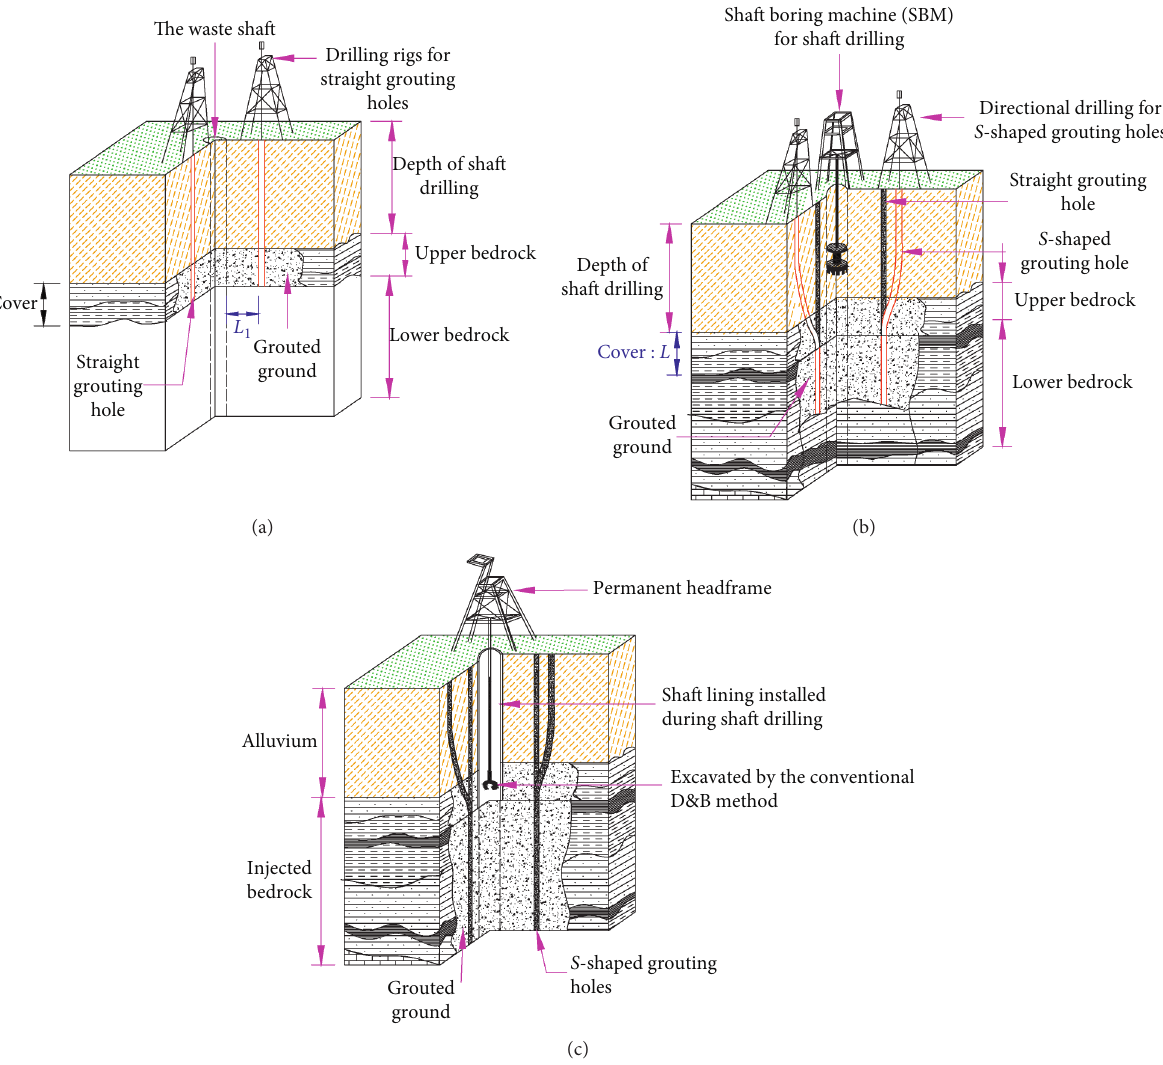
Figure 3: Schematic map of the simultaneous operations. (a) Pregrouting for the upper bedrock. (b) Pregrouting for the lower bedrock during the simultaneous operations. (c) Bedrock is excavated by the conventional D&B method.